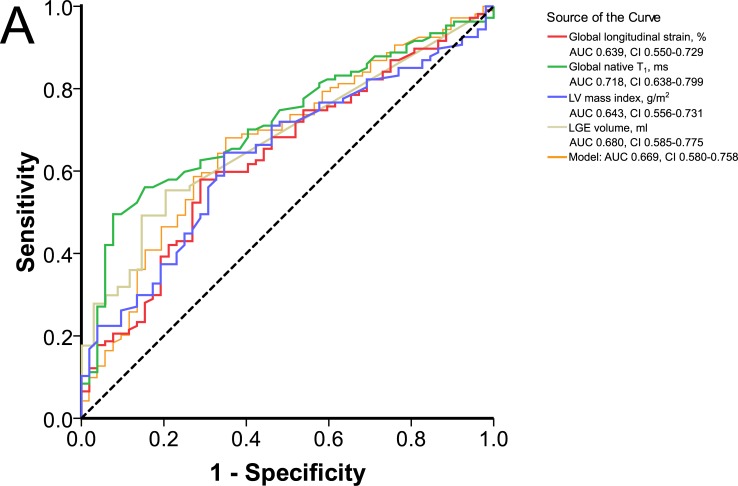
Discrimination of HHD and HCM by CMR markers.Receiver-operating characteristic curves in discrimination between HHD and HCM for single CMR markers and the multivariate regression model listed in Table 4 (GLS and LV hypertrophy (yes/no)).